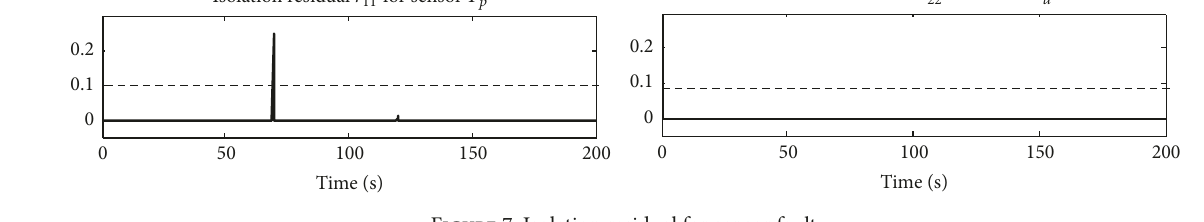
Figure 7: Isolation residual for sensor fault.